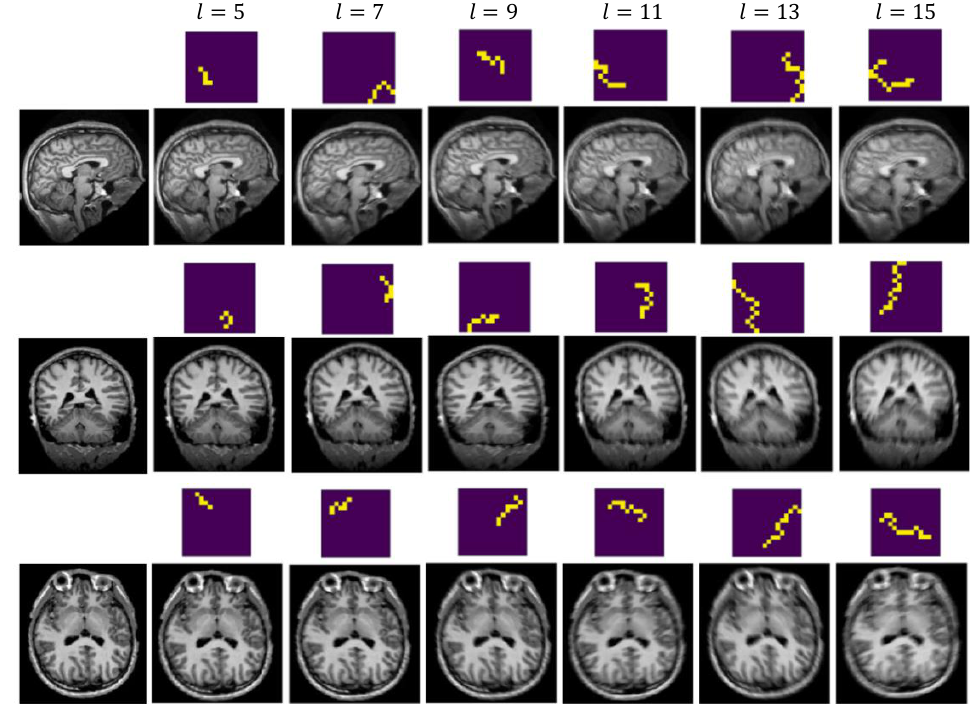
Figure 2. Sample Synthetic Images. Column 1 presents the original sharp images. Columns 2–7 demonstrate generated motion-affected images with kernel length = 5, 7, 9, 11, 13, 15, respectively. The respective convolutional kernel is shown on top of each synthetic image. Images better viewed when zoomed